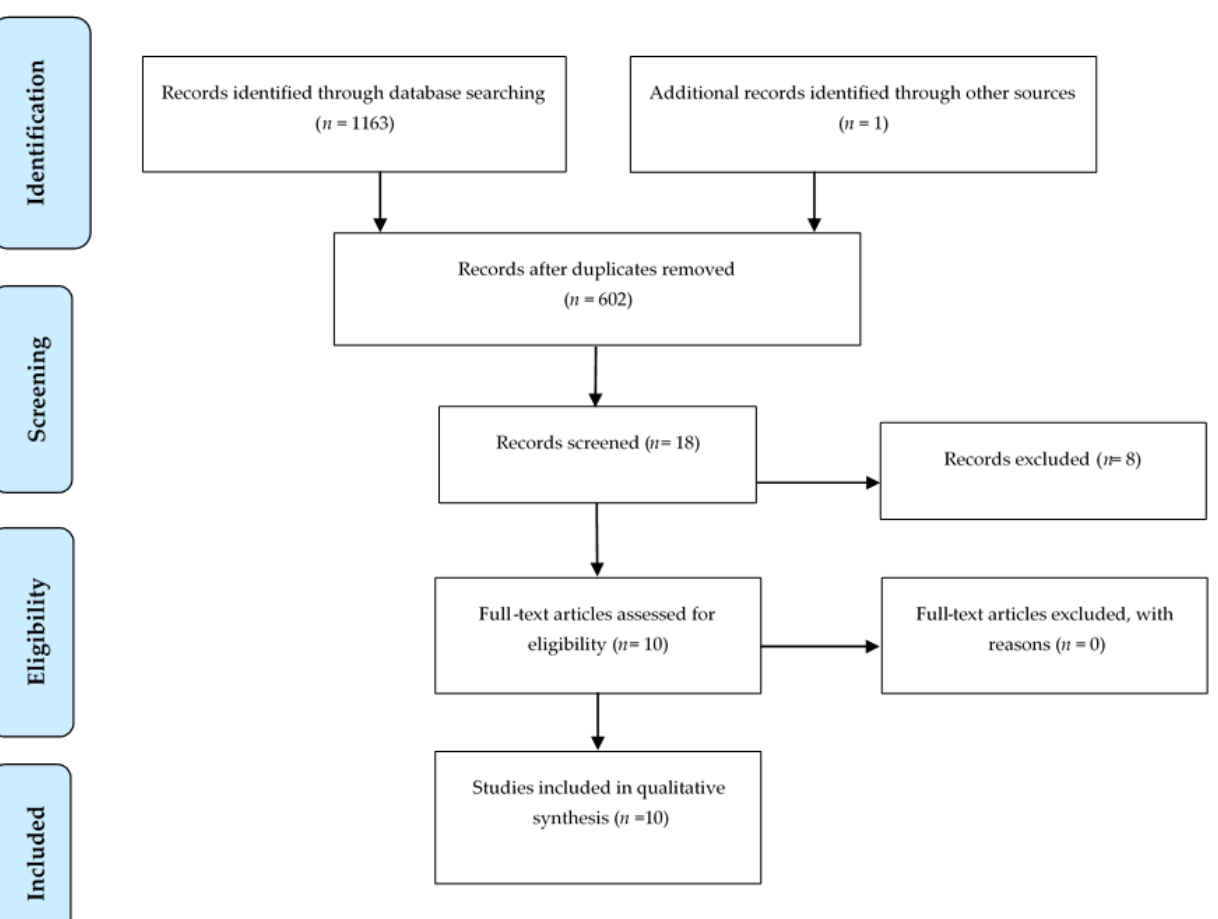
Figure 1. The Preferred Reporting Items for a Systematic Review and Meta-Analysis (PRISMA) flow diagram of record processing and elimination.